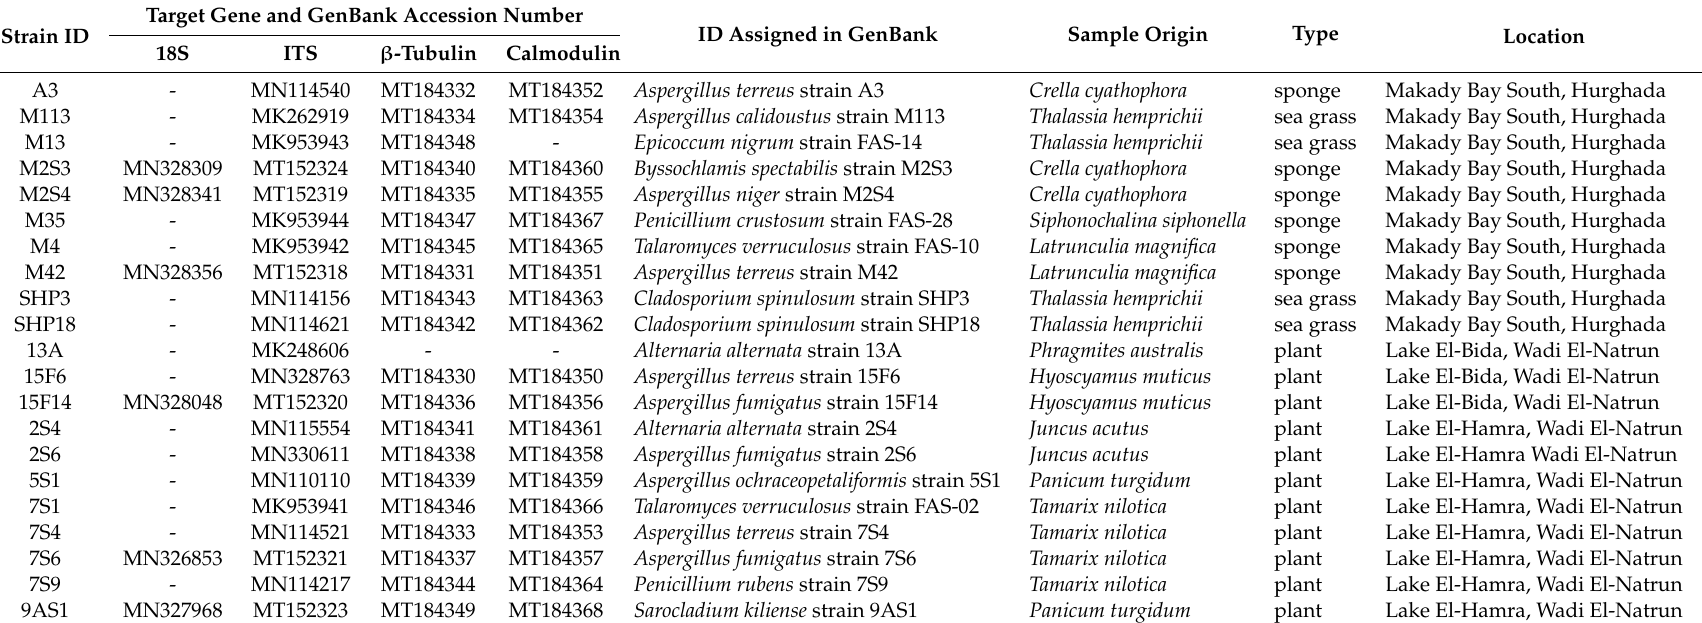
Table 1. Origin and identification of fungal strains by DNA